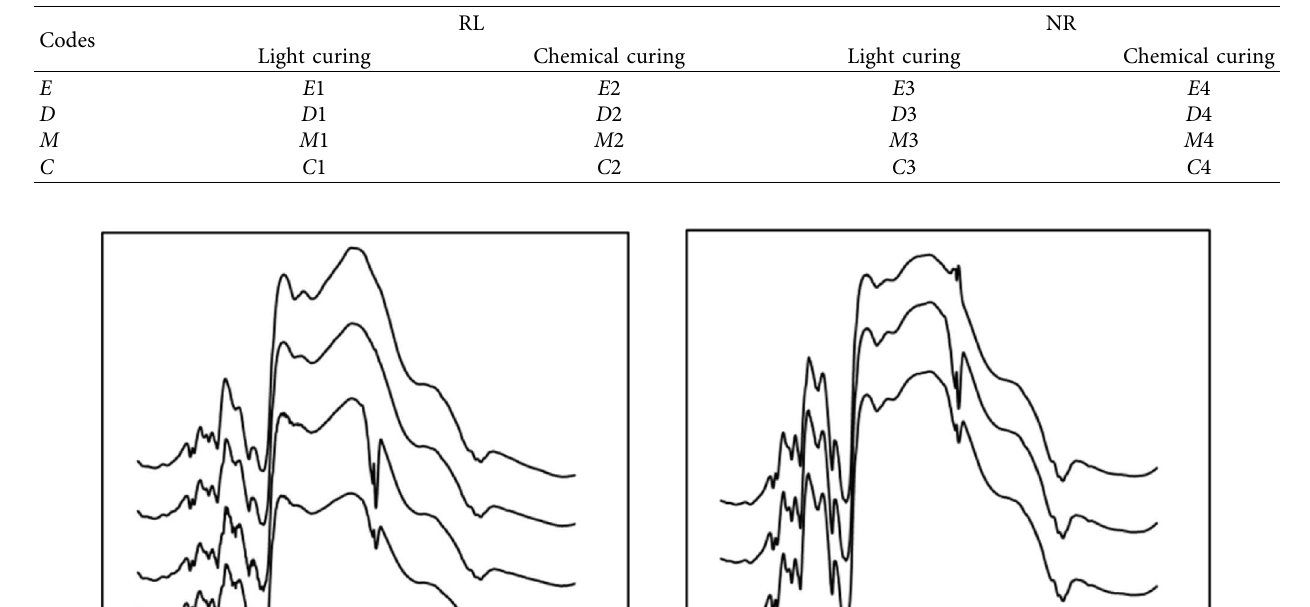
Table 2: Table of groups and